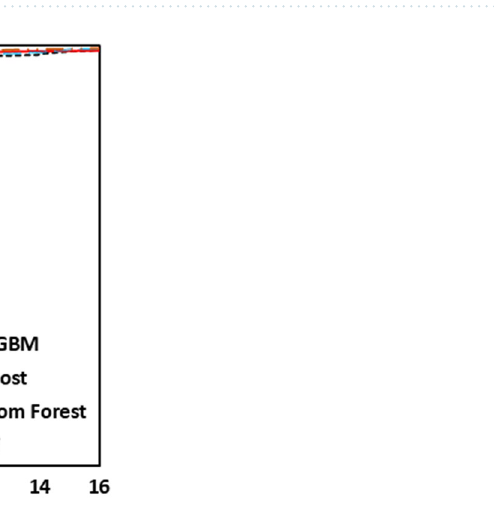
Figure 4. Error distribution plots of machine learning models for training and test sets: ( a ) LightGBM, ( b ) XGBoost, ( c ) GBDT, and ( d ) RF.